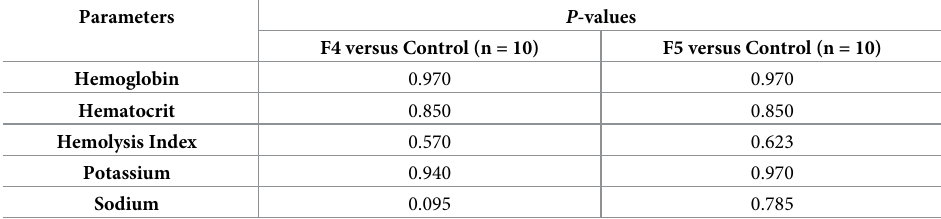
Table 3. Statistical analysis of Phase 2 results using Mann-Whitney U